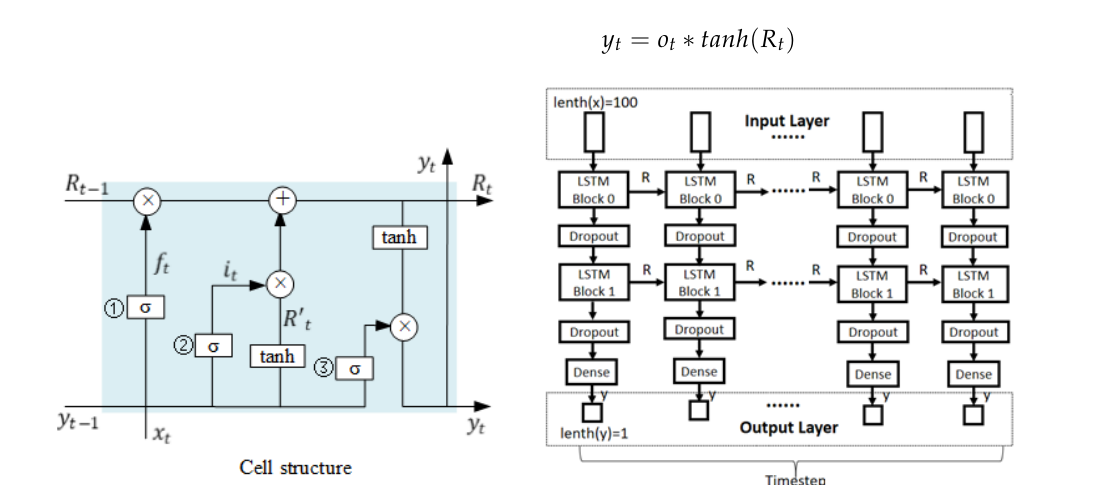
Figure 3. The structure of two-layer LSTM model network.